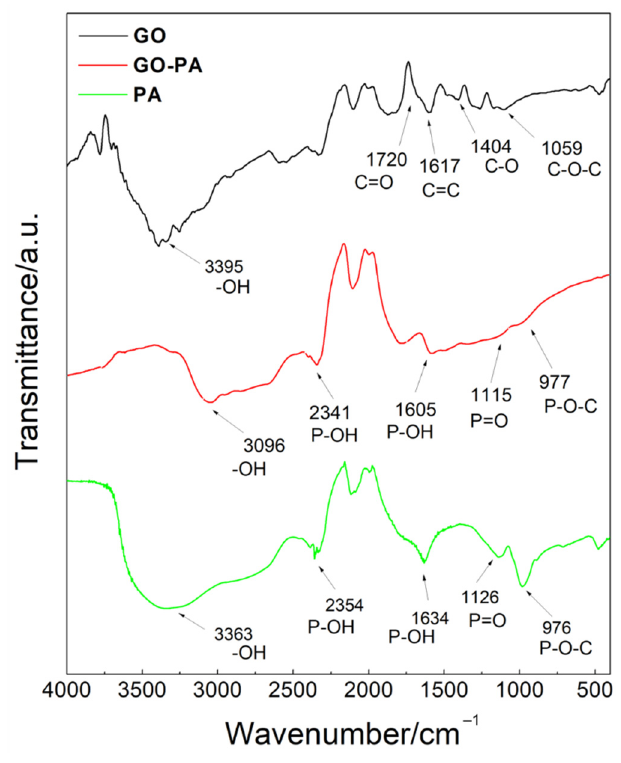
Figure 5. ATR-FT-IR spectra of PA, GO, and GO-PA.